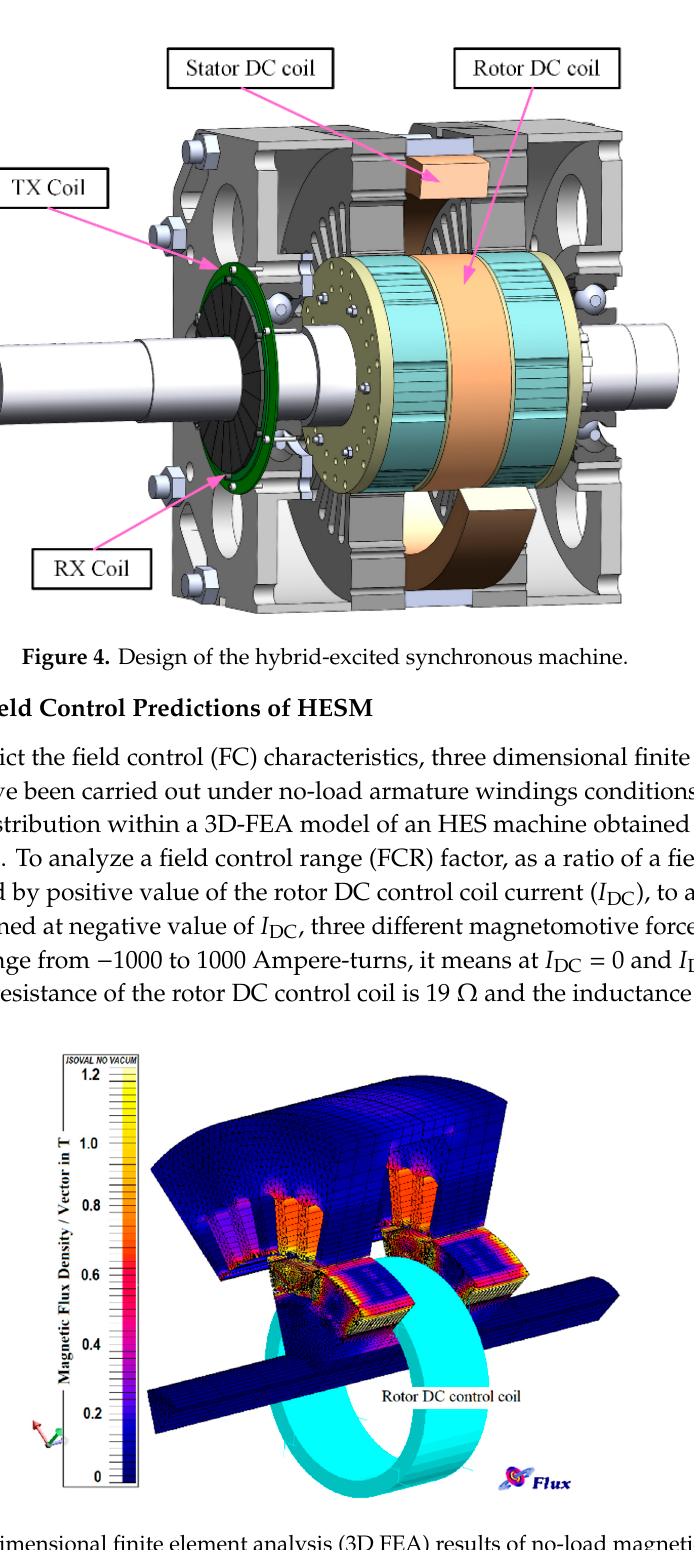
Table 1. The main data of the machine.